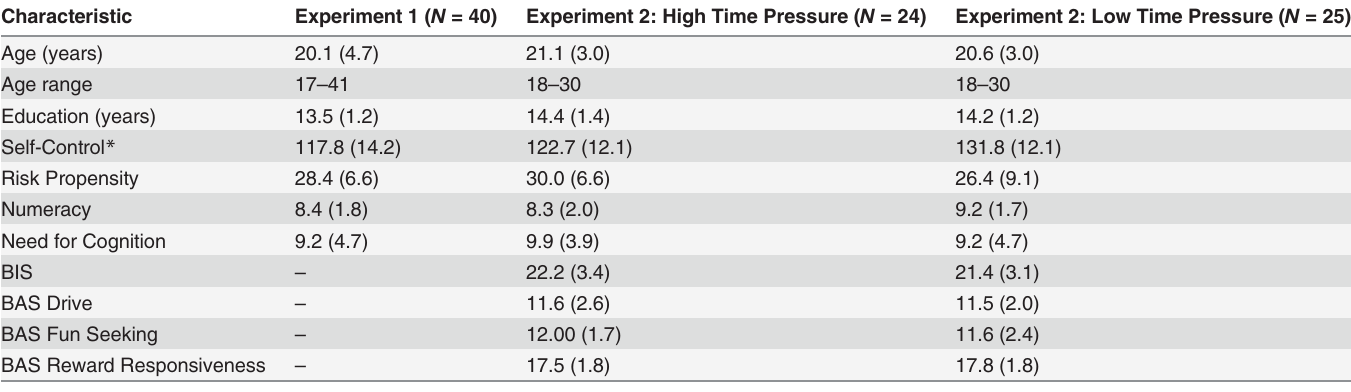
Table 1. Participant characteristics.